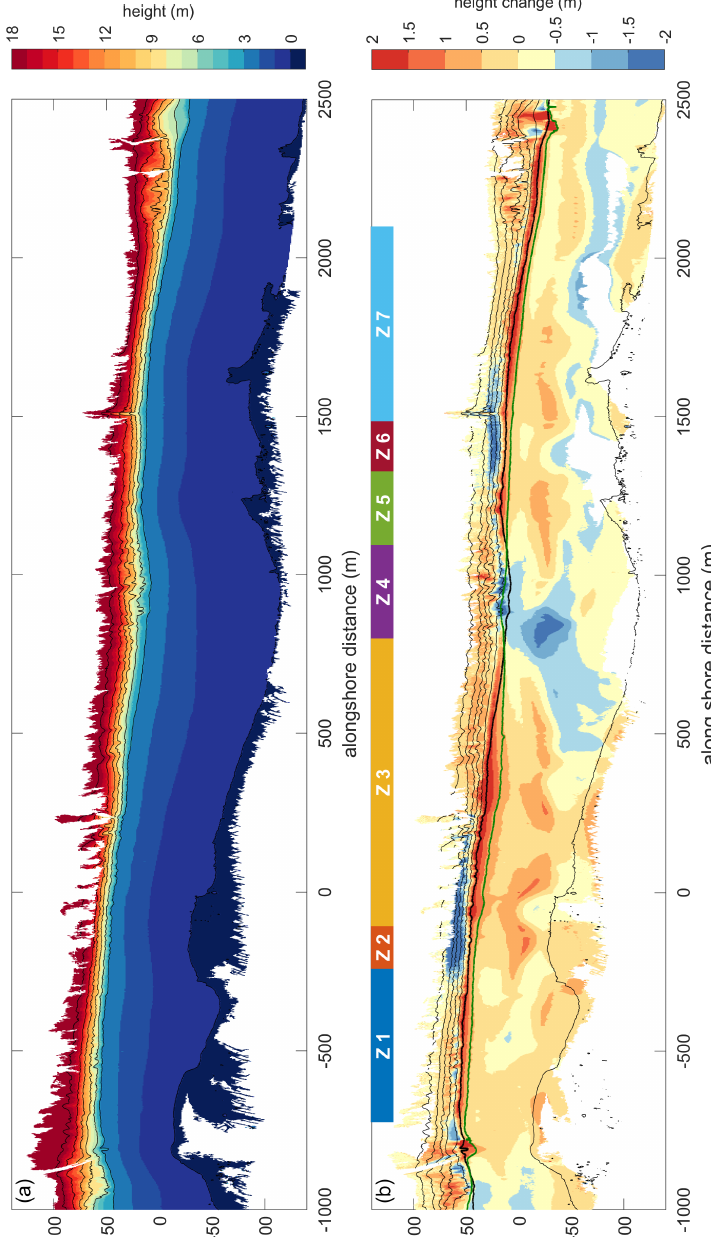
Figure 7. Measured topography in the survey area. ( a ) shows the topography for 14-12-2012; ( b ) shows the change in topography. The thin black lines are bed-elevation contours from the Dec13 survey, starting at MSL with a 3-m interval. The +3 m contour for the Dec13 survey is shown as a thick black line and the location of the 3-m contour in the Apr16 survey is shown with a thick green